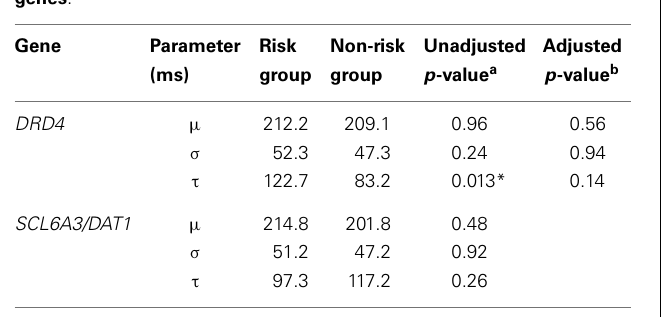
Table 2 | Ex-Gaussian parameters in subjects presenting “risk” versus subjects presenting “non-risk” alleles for DRD4 and SCL6A3/DAT1 genes .